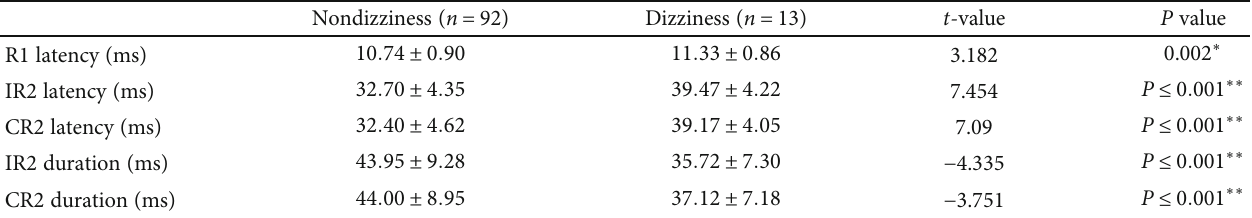
Table 5: Di ff erences in blink re fl ex between nondizziness and dizziness groups.